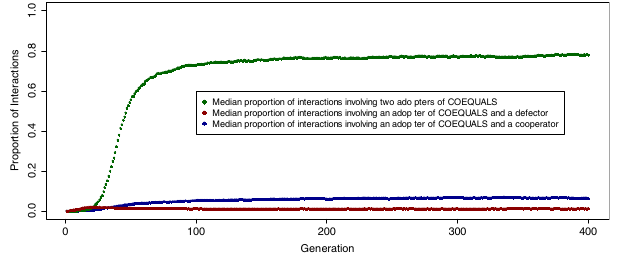
Figure 4. COEQUALS generates positive assortment. To understand whether COEQUALS generates positive assortment, we recorded the pair of strategies that agents used in every social interaction of our simulation; then, for every generation, we calculated the proportion of social interactions involving each possible pair of strategies. This created a distribution of 5,000 proportions indicating the share of social interactions involving each possible pair of strategies in each generation. Figure 3 plots the median of these distributions, by generation, for all interactions involving COEQUALS. It shows that, from the 21 st generation onward, the median proportion of interactions involving two adopters of COEQUALS (dark green points) exceeds the median proportion of interactions involving a COEQUALS adopter and a defector (dark red points). From the 10 th generation onward, the median proportion of interactions involving two adopters of COEQUALS exceeds the median proportion of interactions involving a COEQUALS adopter and a cooperator (dark blue points). Furthermore, within the first 50 generations, we find that the median proportion of interactions involving two COEQUALS players exceeds 50%, thus indicating that COEQUALS agents frequently begin to channel cooperation successfully to fellow COEQUALS adopters early in simulation runs. By the 200 th generation, the median proportion of interactions involving two COEQUALS adopters reached 0.76 and it remains roughly at this value for the remaining generations of the simulation.